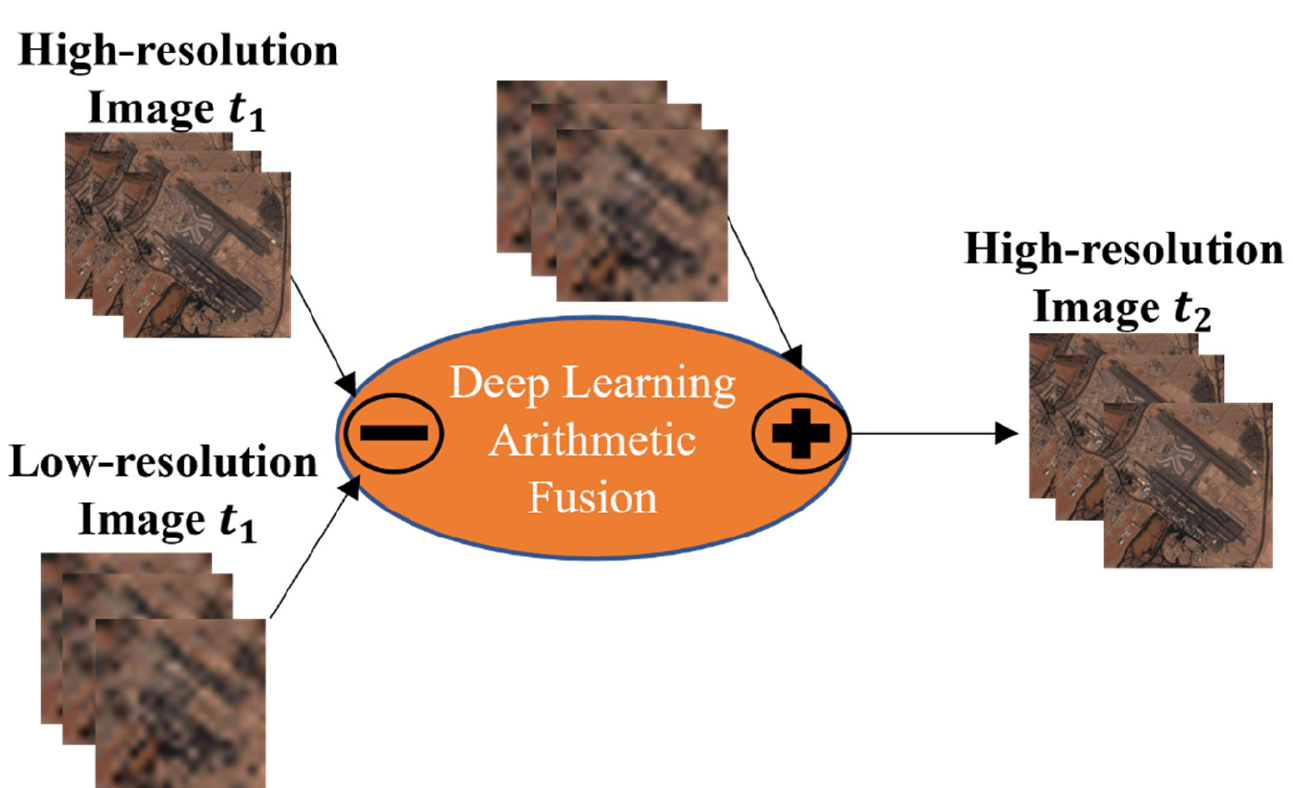
Figure 2. Diagram of the proposed deep learning fusion model.